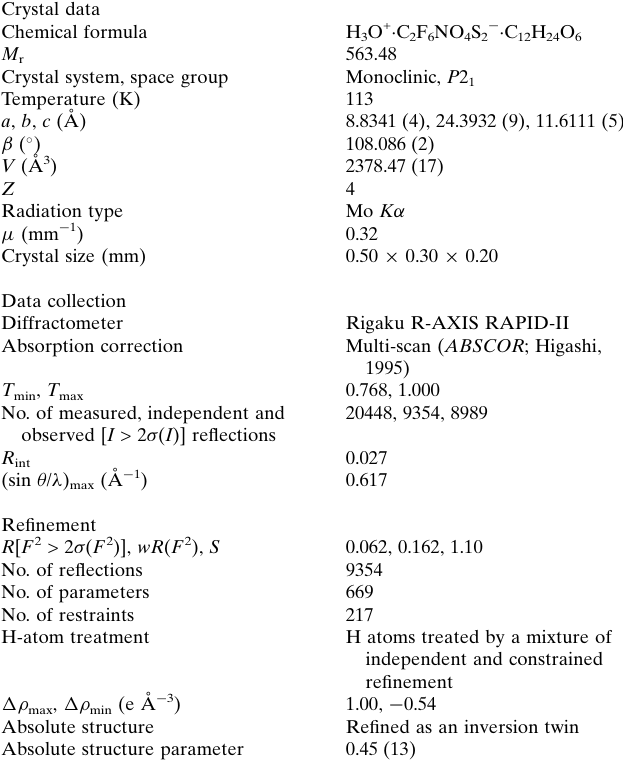
Table 2 Experimental details. Crystal data Chemical formula